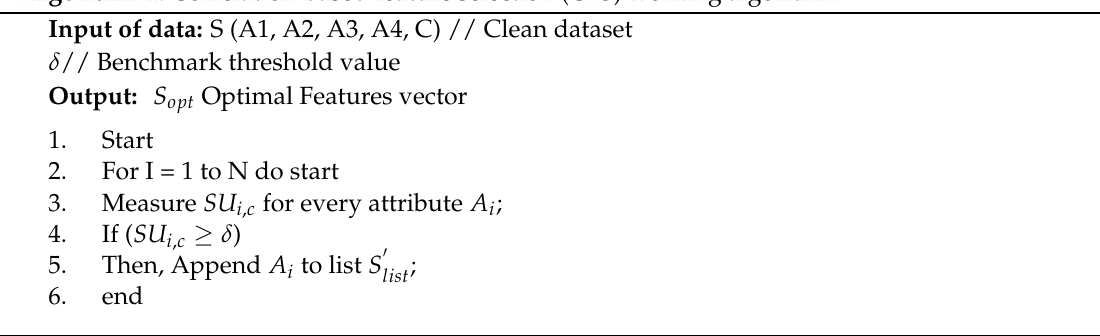
Algorithm 1: Correlation-based feature selection (CFS) working algorithm.